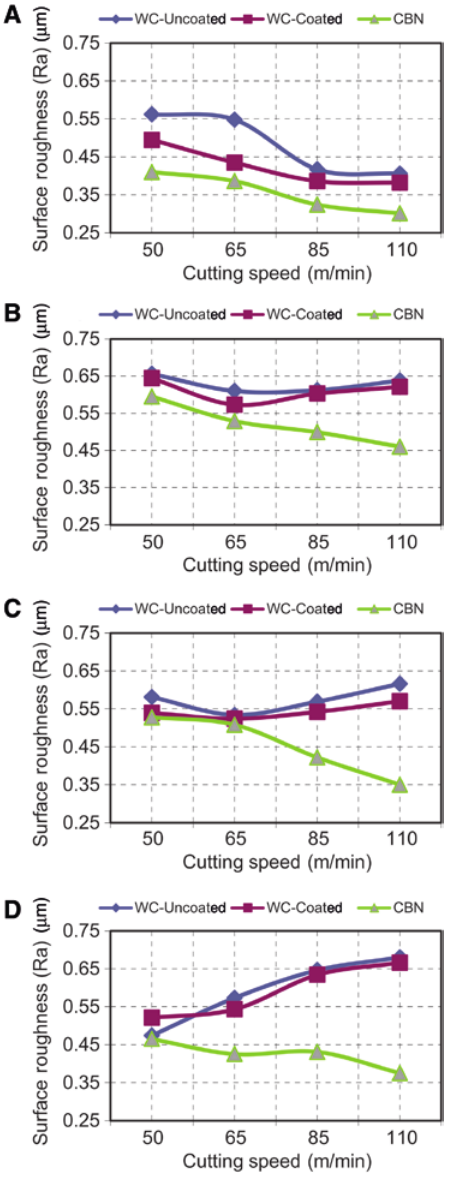
Figure 8: Surface roughness variations depending on cutting speed: (A) Alumix 123, (B) 5% B